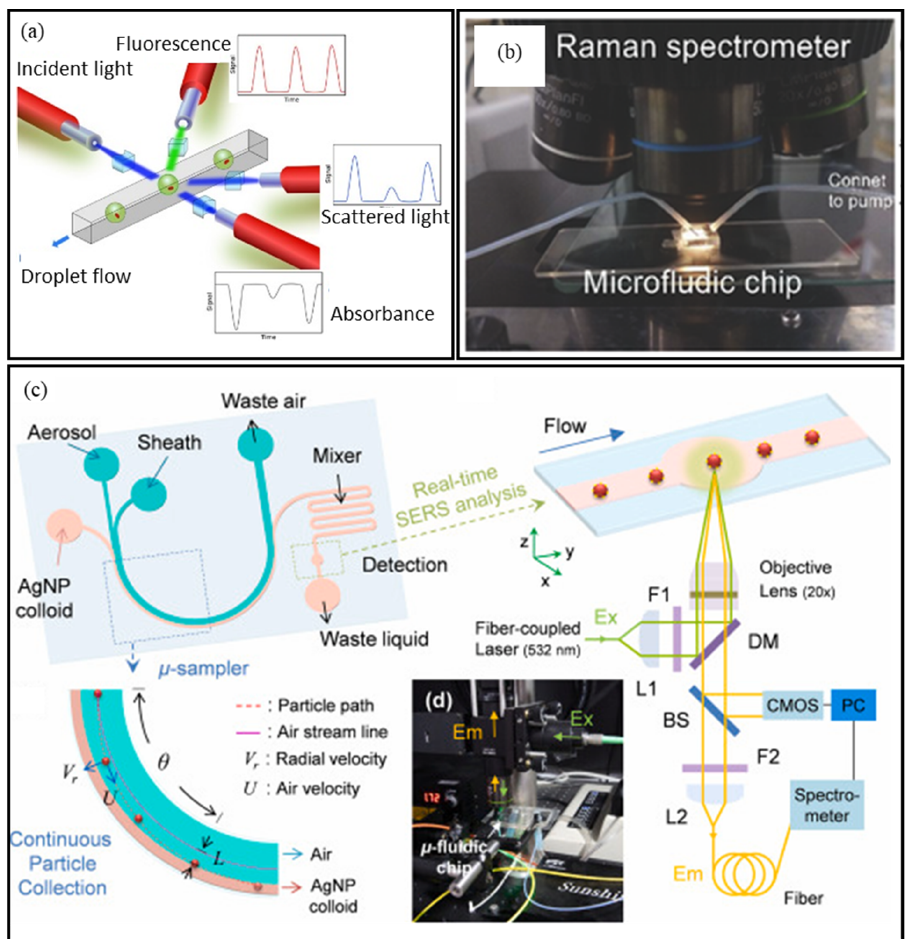
Figure 8. Optofluidic sensing based on light scattering. ( a ) Biological sample sensing in droplets in a cytometer. SERS-based sensing: ( b ) cadmium ion and ( c ) airborne microorganisms. ( a ) Reprinted